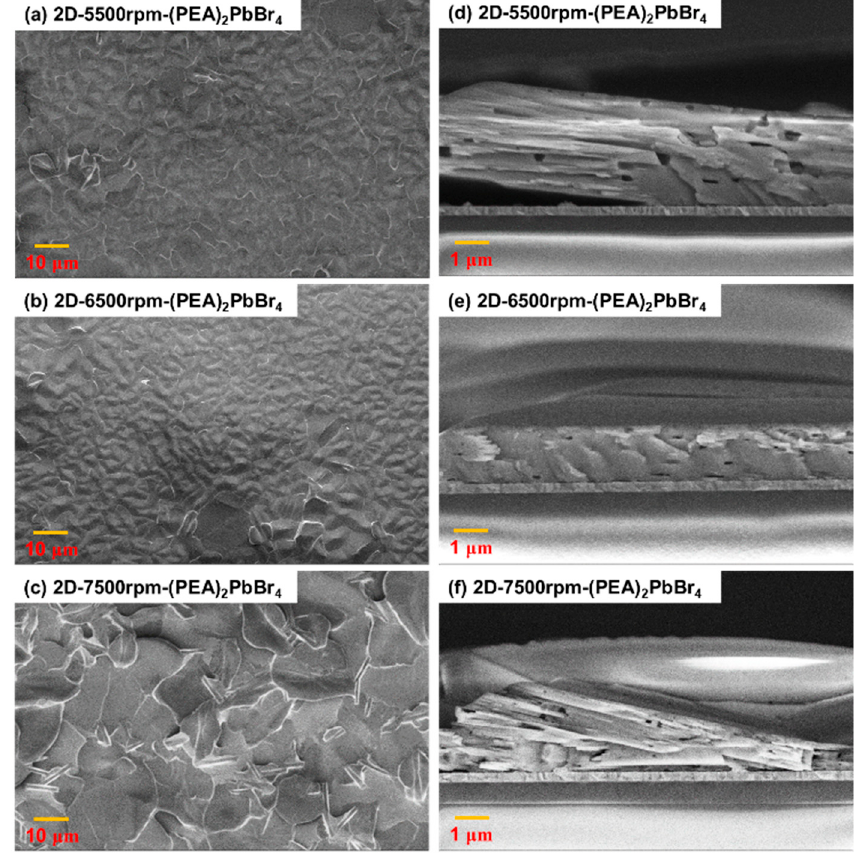
Figure 7. ( a – c ) Top view and ( d – f ) cross-section field-emission scanning electron microscope (FESEM) images of 2D-(PEA) 2 PbBr 4 films formed with different spin speeds.